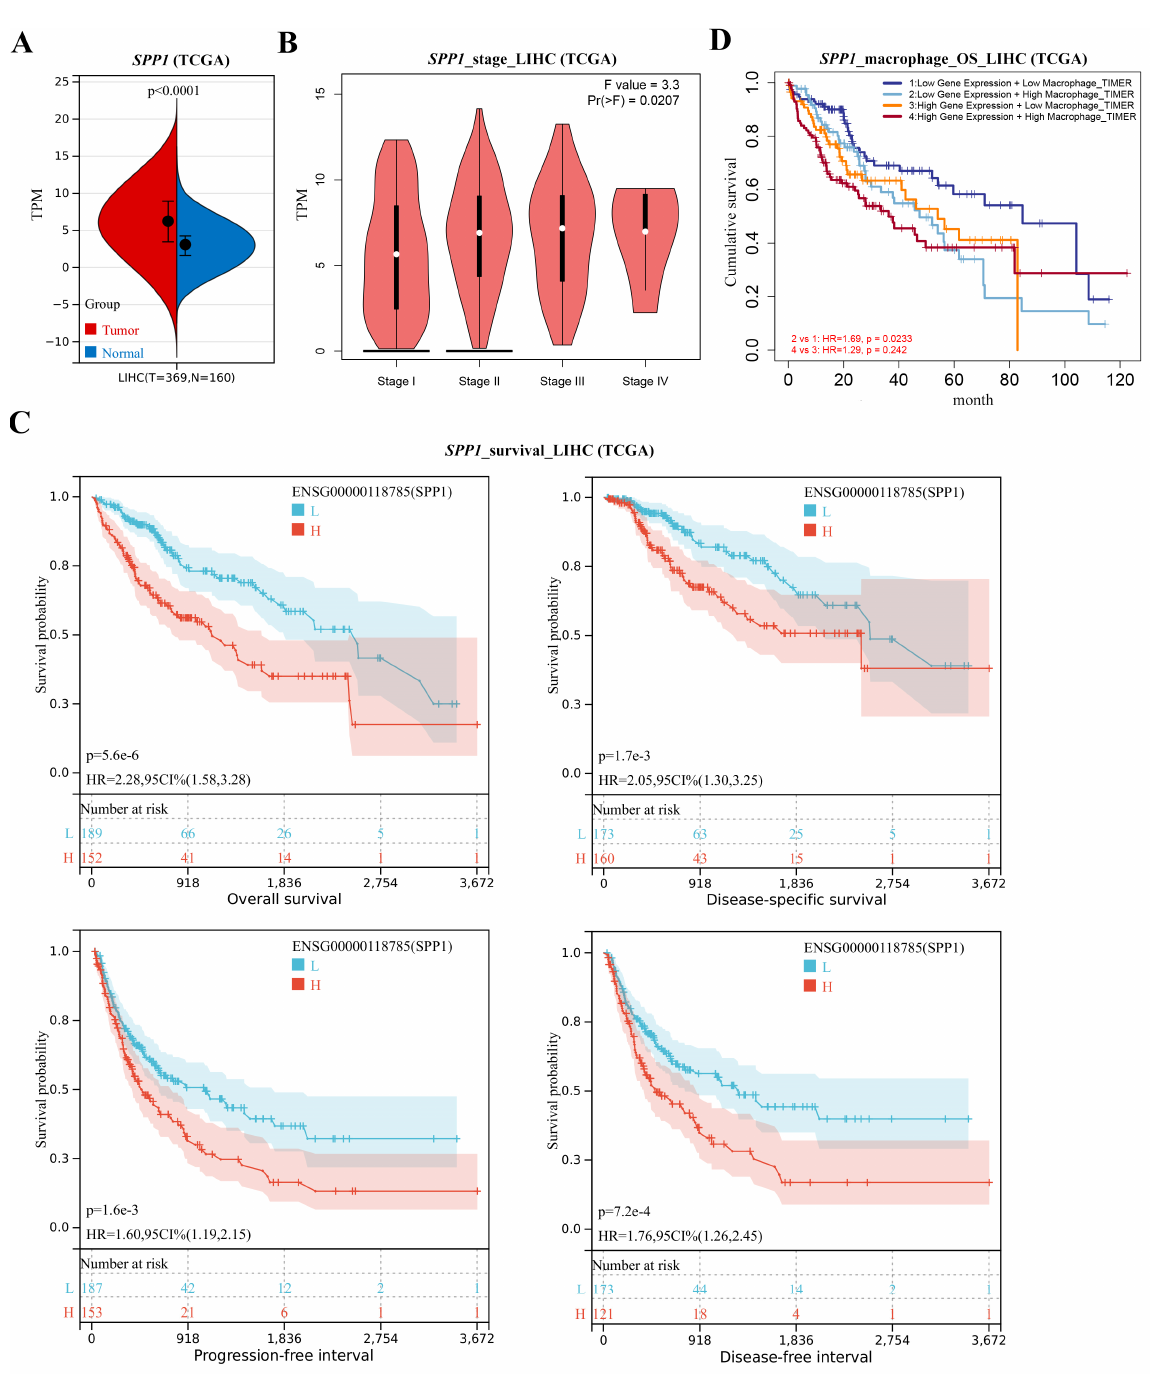
Figure 5. Annotation of SPP1 in LIHC/HCC. ( A ) SPP1 expression was compared in LIHC (TCGA) dataset. ( B ) The correlation of SPP1 expression and tumor stages was analyzed in LIHC (TCGA) dataset. ( C ) Correlation of SPP1 expression and survival time (OS, DSS, PFS, and DFS) was analyzed in LIHC (TCGA) dataset. p value is displayed in scientific notation (e.g. 1.6e ‐ 3 = 1.6X10 ‐ 3 ). ( D )